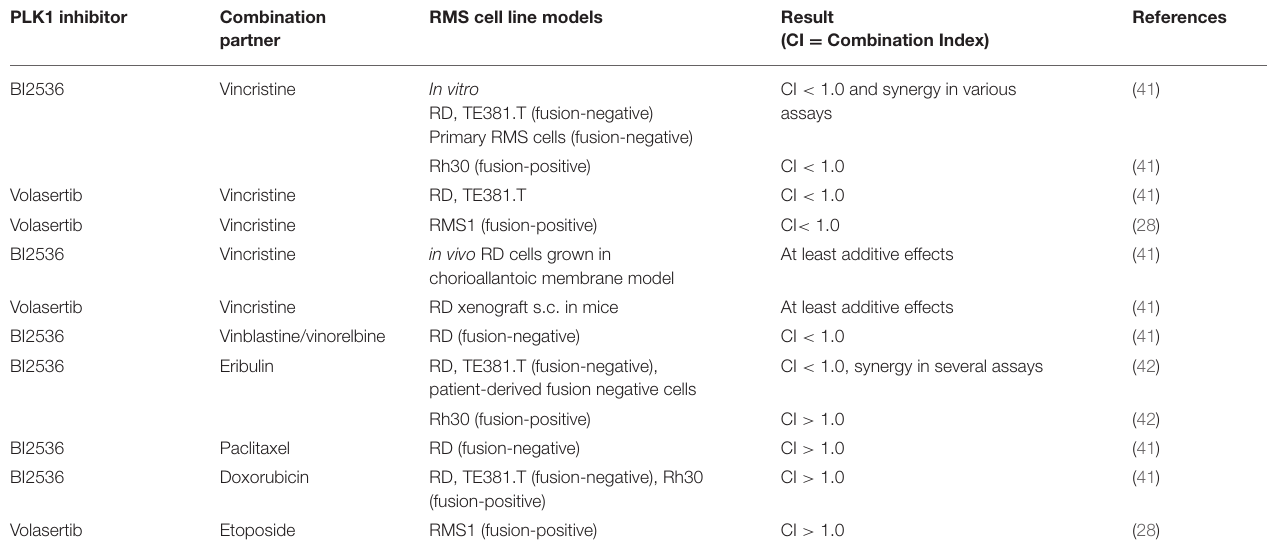
TABLE 1 | Summary of rhabdomyosarcoma (RMS) preclinical studies for PLK1 inhibitors combined with other